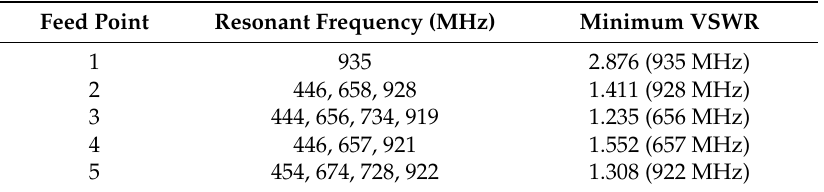
Figure 7. Current distribution of the antenna. Table 1. Resonant points and minimum standing wave ratio at different feed